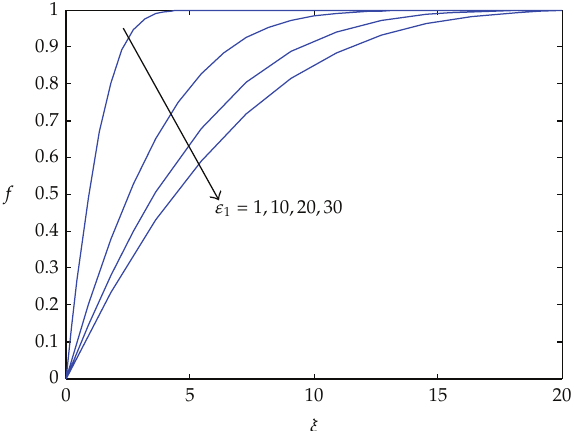
Figure 1: E ff ect of ε 1 parameter on the similarity function f related to the x component of velocity (cid:7) ε 2 (cid:5) 1, n (cid:5) 2 (cid:8) .